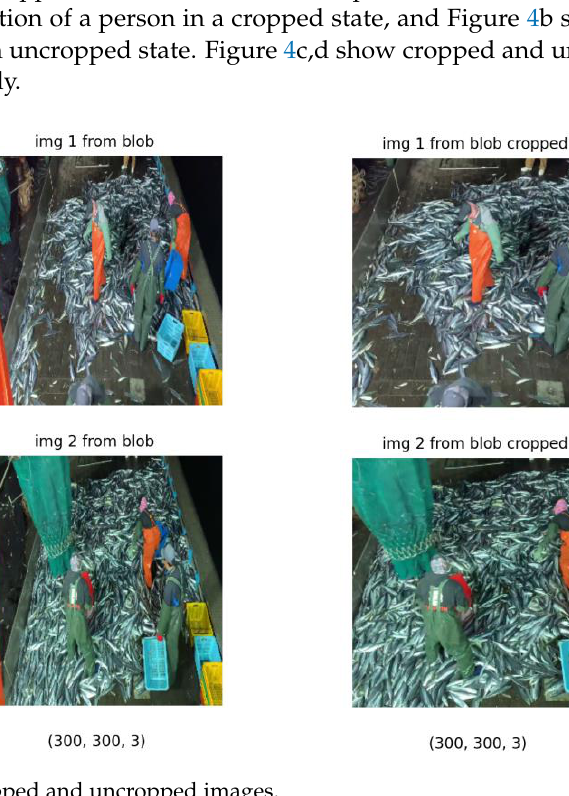
Figure 3. A comparison of cropped and uncropped images.